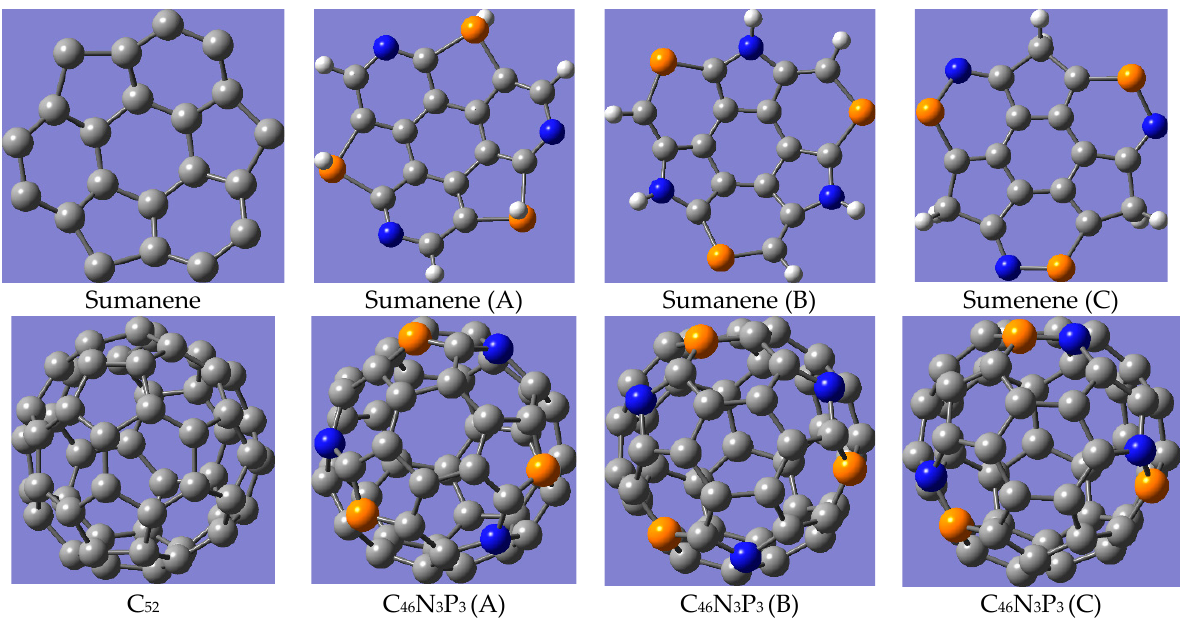
Figure 2. Fullerenes investigated as delivery systems for the metal-phthalocyanins. (C atoms—grey, N atoms—blue, P atoms—orange).